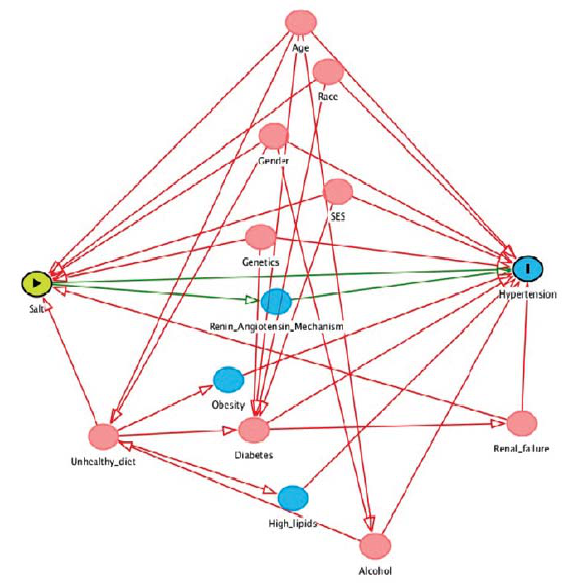
Figure 4. DAG using Dagitty to illustrate the association between salt and